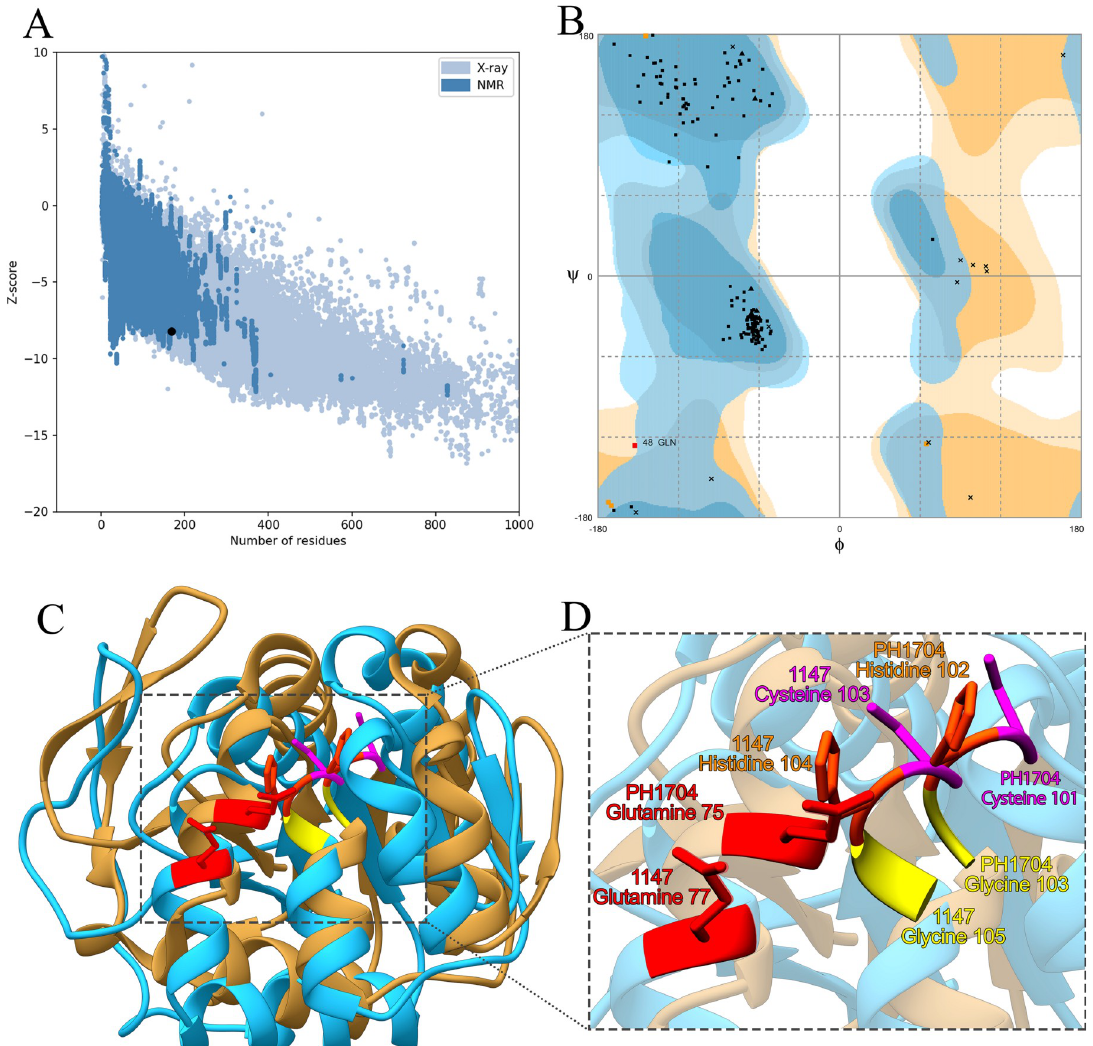
Fig 3. The validation of homology modeling results. (A) ProSA Z-score analysis for homology modeled protease 1147. The plot showed that the black spot (predicted model) with the Z-score value of -6.34 is within the range of native conformation of all proteins chains in PDB determined by X-ray crystallography or NMR spectroscopy concerning their length. (B) Ramachandran’s analysis depicts that 98% of residues fall within the favoured, allowed, and acceptable regions, while the outlier region represents only 2%. (C) The 3D superimposition between the native structure of Pyrococcus horikoshii chain A (beige) and predicted protease 1147 structure (blue). The RMSD is 0.51 Å . (D) Catalytic tetrad residues are shown and labeled.